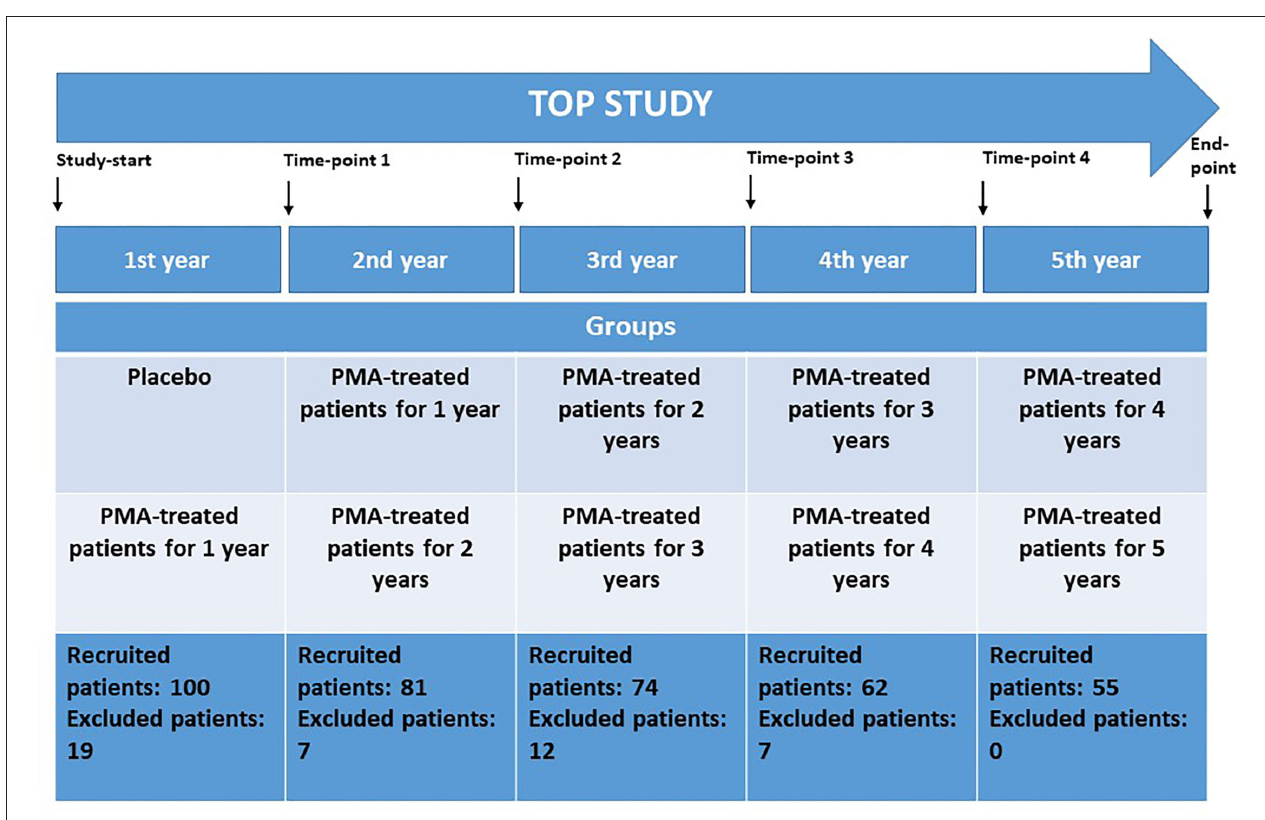
FIGURE 1 | The TOP study design and corresponding study time measurement points at the end of each study year. Study groups and recruited patients at the beginning of each study year are given. Placebo-control in the first study year; PMA-zeolite treated patients—groups receiving PMA-zeolite supplementation for 1 year up to 5